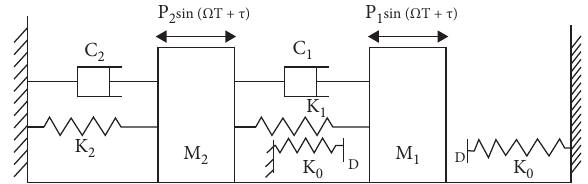
Figure 1: The model of the two-degree-of-freedom vibroimpact system with symmetrical